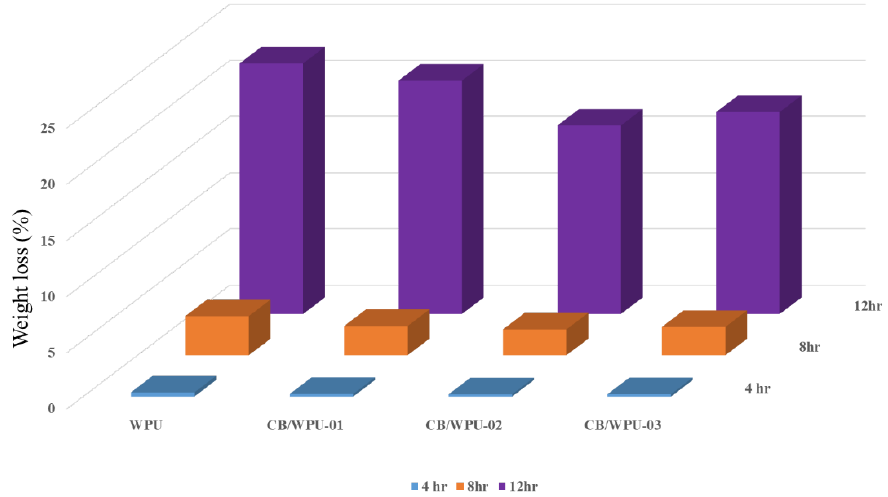
Figure 7. Weight loss of hydrolytic degradation results of the CB/WPUs.